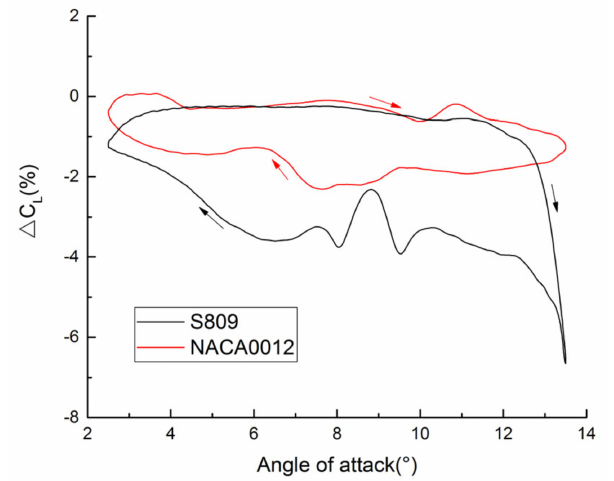
Figure 9. Relative increment loops of two airfoils after loading particles with a concentration of